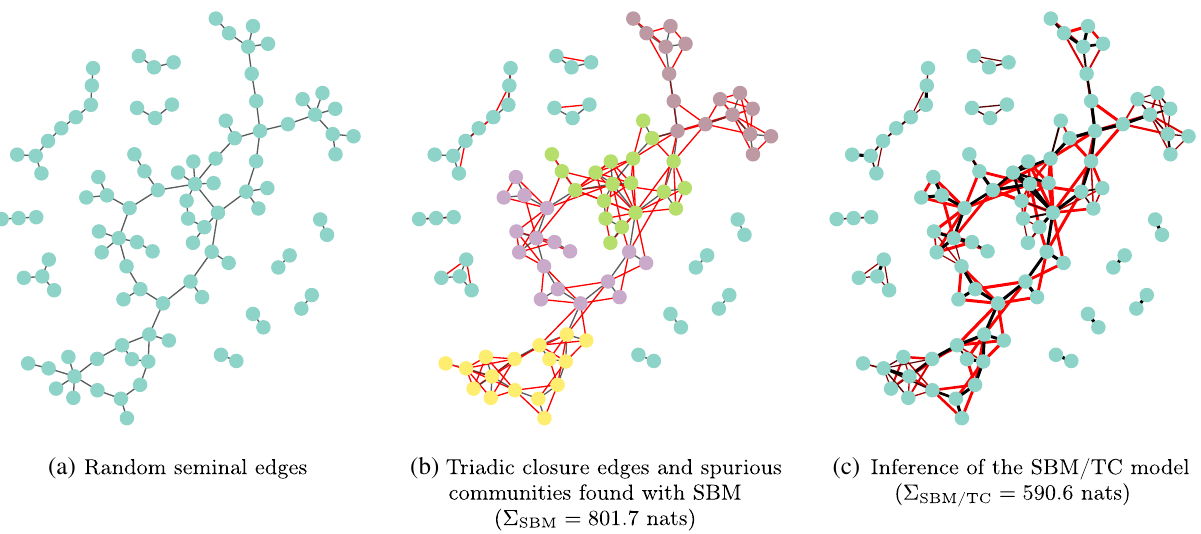
FIG. 3. (a) Example artificial network generated as a fully random graph with a geometric degree distribution, N ¼ 100 nodes and E ¼ 94 edges, and (b) a process of triadic closure based on network (a) with parameter p shown in red. We also show the partition found by fitting the SBM to the resulting network and the description length obtained. (c) Result of inferring the SBM/TC model, which uncovers a single partition — no community structure — and the closure edges shown in red (the thickness of the edges corresponds to the marginal probabilities π We also show the description length of the SBM/TC